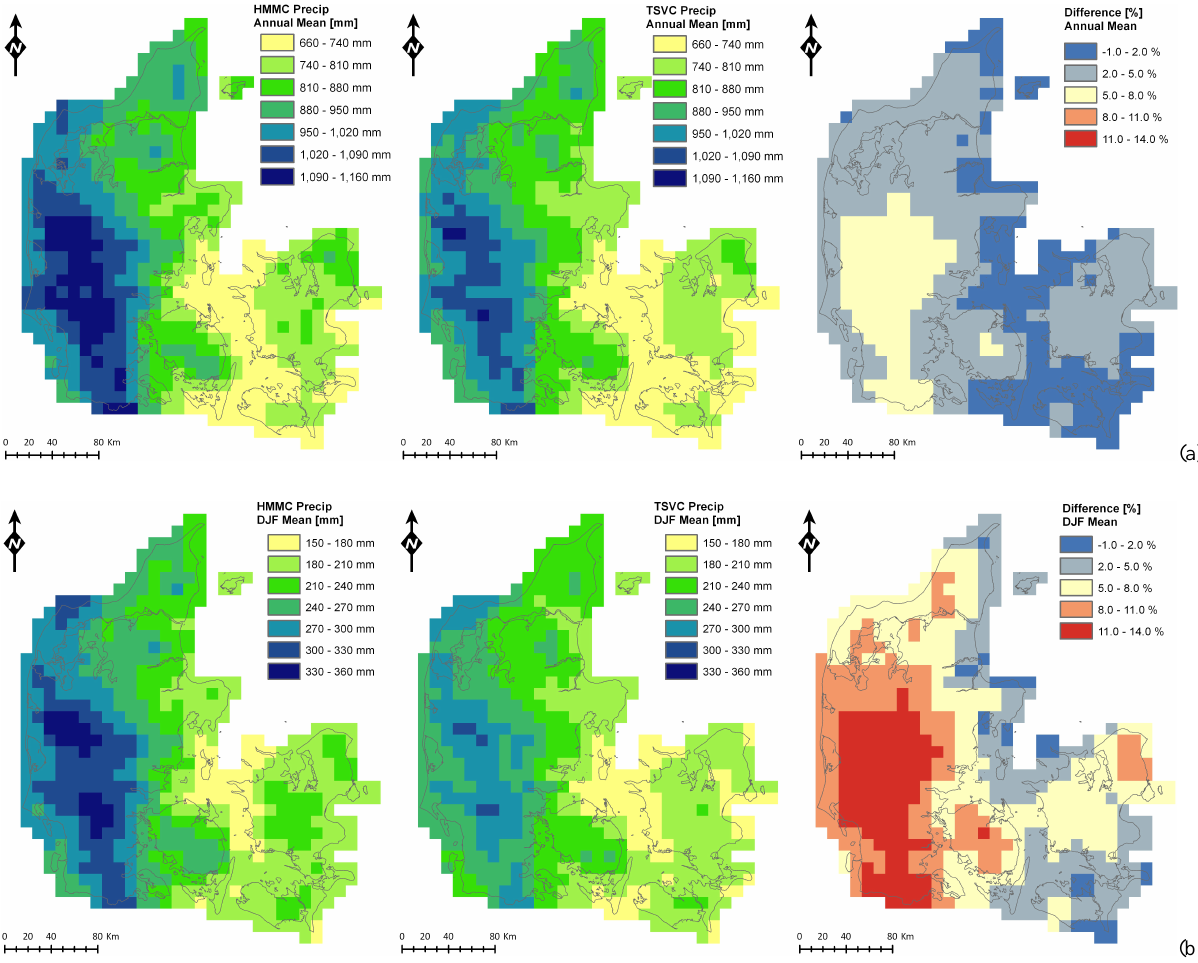
Fig. 1. Spatial distribution of mean annual precipitation (a) and winter precipitation (DJF) (b) for Denmark with HMM and TSV precipitation correction.